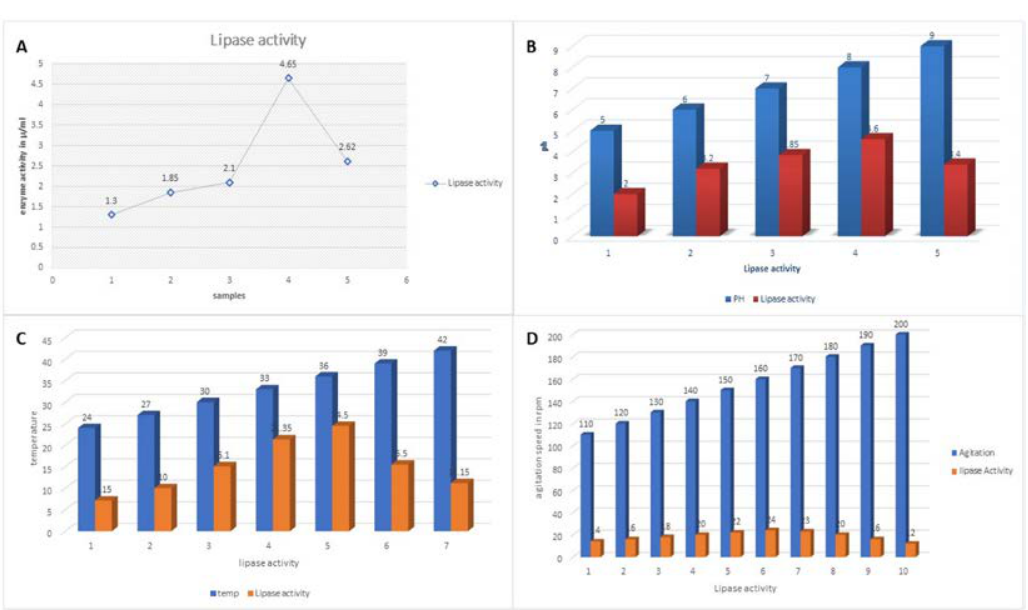
Fig.4. Outcomes of the optimation done for the lipase production . (A) A presentation of lipase activity for the samples considered. (B) Effect of pH on lipase activity. (C) Effect of temperature on lipase activity. (D) Effect of agitation on lipase activity.